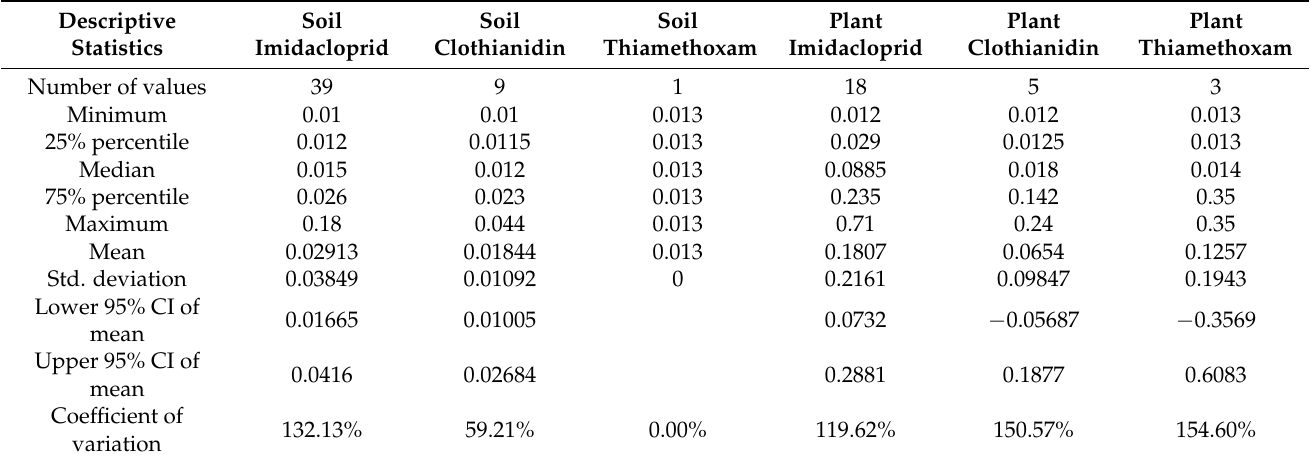
Figure 1. Values of neonicotinoids above the LOQ detected in analyzed samples. Table 5. Descriptive statistical analysis of neonicotinoids values detected above